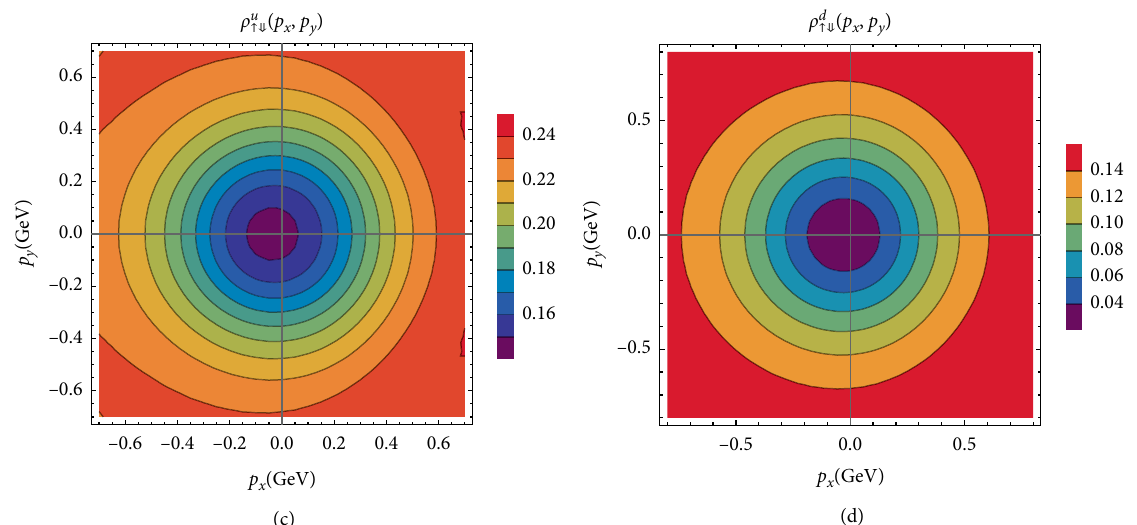
( b , p ) in transverse impact-parameter plane and transverse momentum plane for 𝑢 -quark ↑⇓ ⊥ ⊥